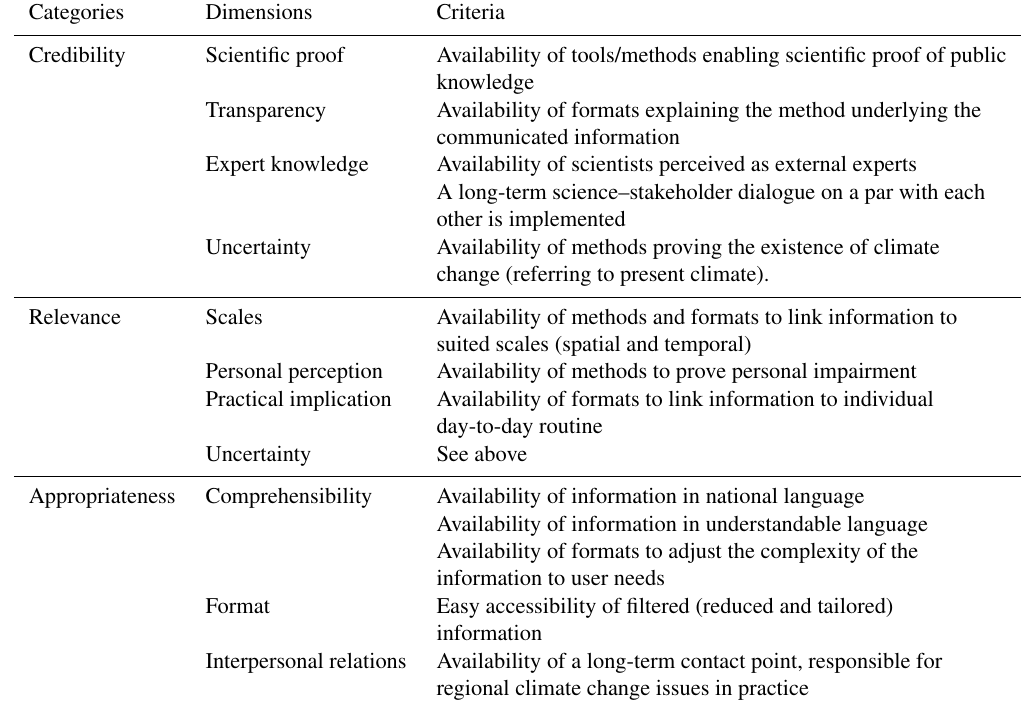
Table 1. Stakeholder-based evaluation categories, dimensions and criteria according to a regional climate service.